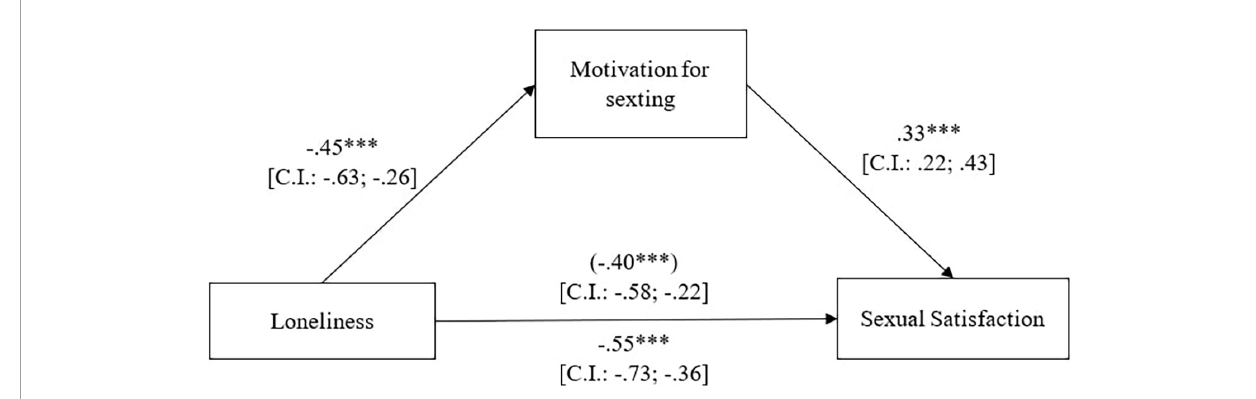
FIGURE2 The effects of loneliness on sexual satisfaction via motivation for